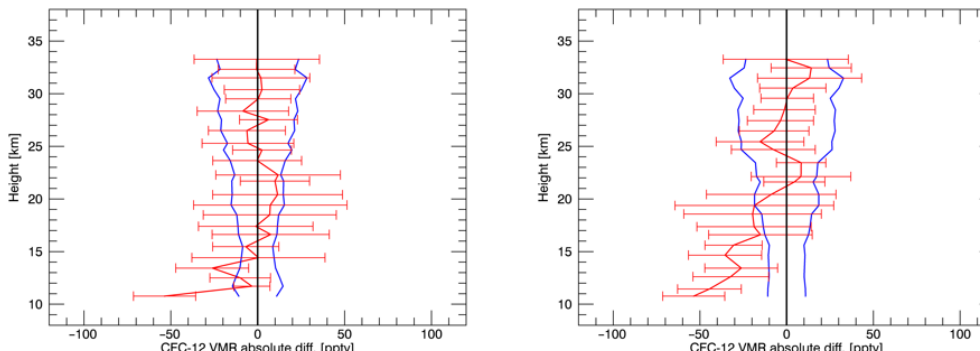
Figure 13. Same as Fig. 5, but instead of CH 4 now CFC-12.